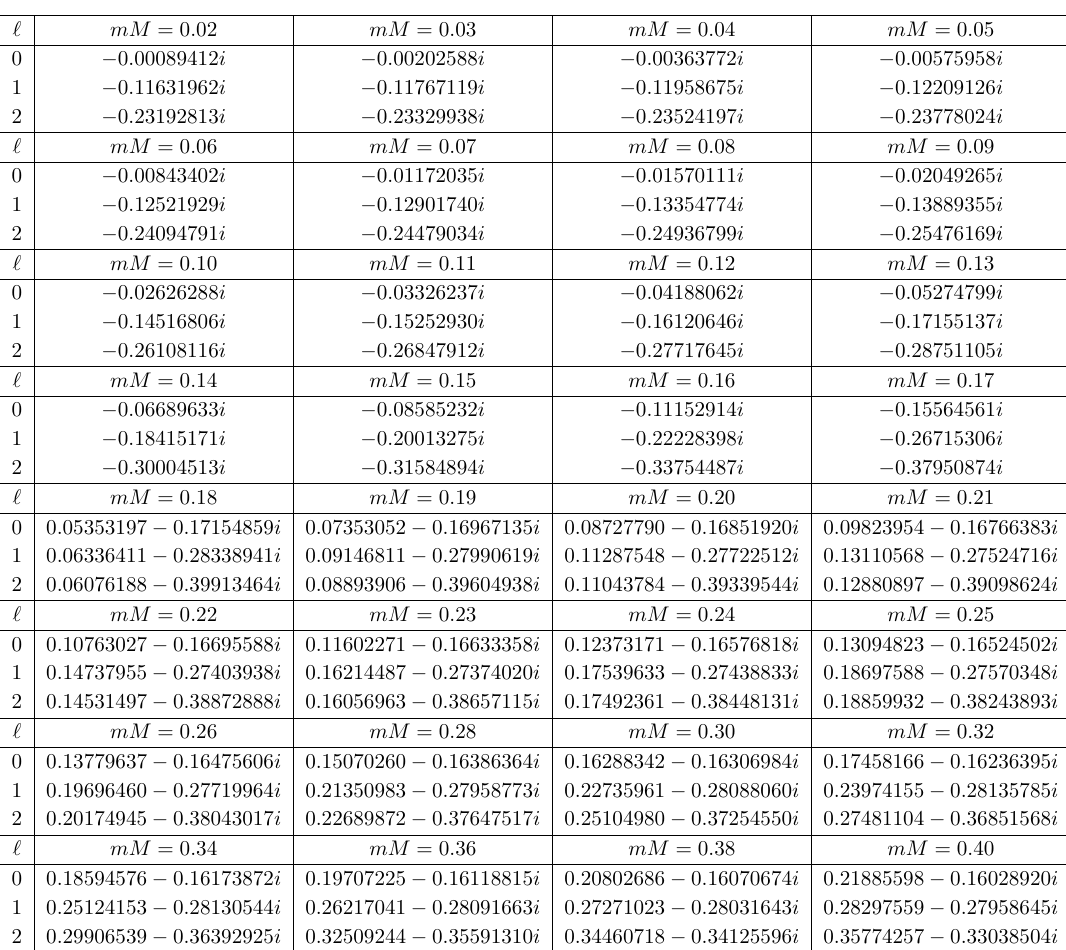
Table 4 . Dominant dS modes ( n dS = 0) for massive scalar (cid:12)elds with ‘ = 0 ; 1 ; 2 ; 10 ; 20, and 30 in the background of a Schwarzschild-de Sitter black hole with M 2 (cid:3) = 0 : 04.